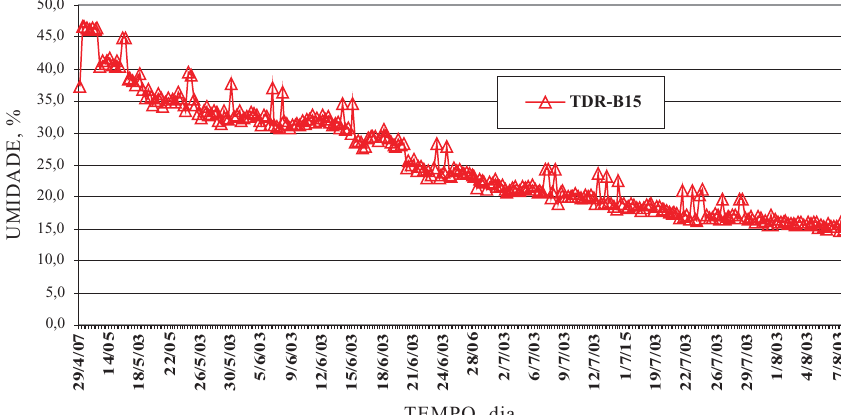
Figura 17. Aspecto da variação de umidade a partir dos dados coletados pelo TDR-B15. Diene